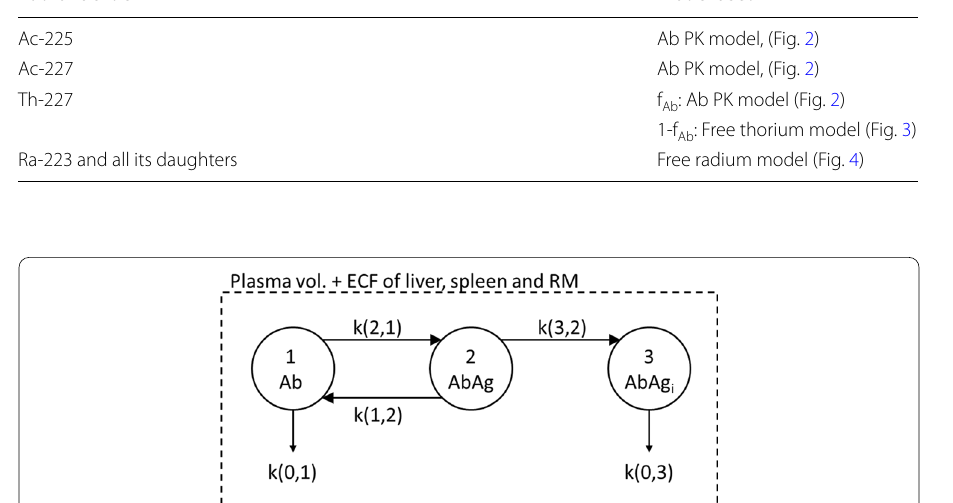
Table 1 PK models used for each radionuclide Radionuclide